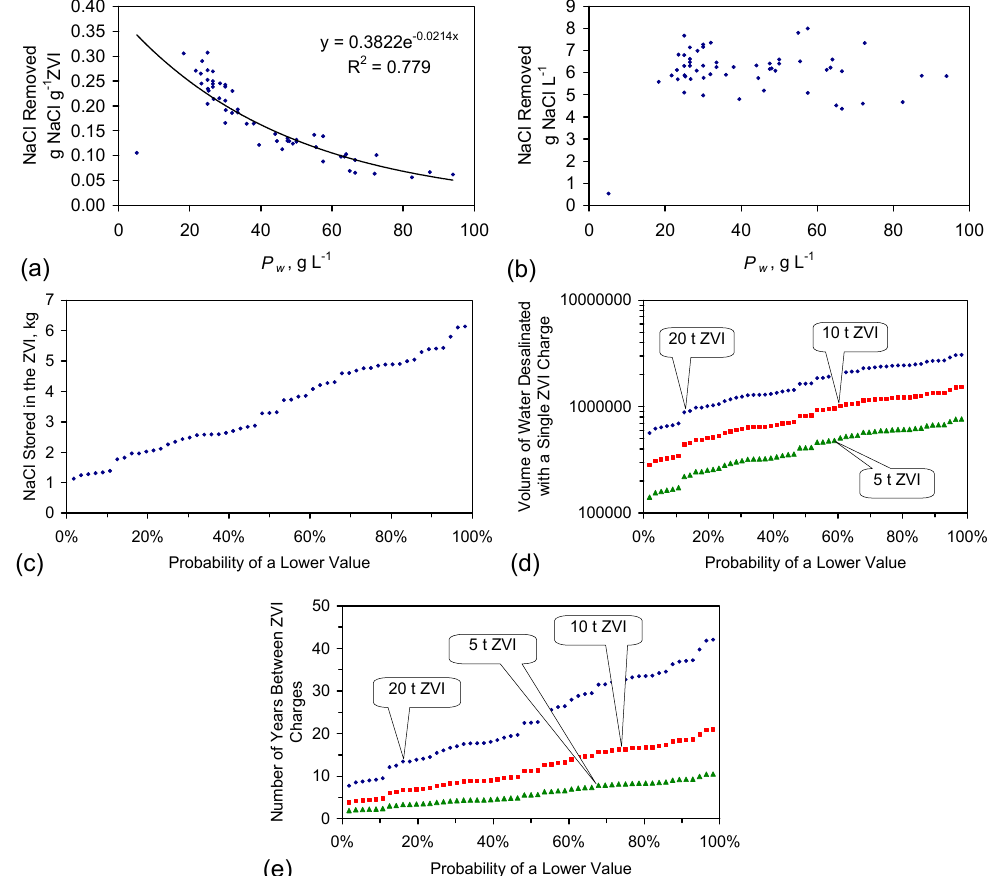
Figure 17. ST Desalination Pellets. Data Trial Duration: 230 days; n = 55; Data Source: [16]. ( a ) Relationship between NaCl removed (g·g − 1 ZVI) and P w , g NaCl·g − 1 ZVI: Data [16]; ( b ) Relationship between the total amount of NaCl removed, g·L − 1 , and P w , g NaCl·g − 1 ZVI: Data [16]; ( c ) Implied relationship between probability and the amount of NaCl (kg) that can be sequestered in 20 kg of pellets. Mean = 3.45 kg; Standard Deviation = 1.44 kg; 1st Quartile = 2.30 kg; Median = 3.29 kg; 3rd Quartile = 4.77 kg; ( d ) Volume of water than can be treated by a single ZVI charge before the ZVI needs to be recharged as a function of the amount of ZVI placed in a 4000 m 3 treatment zone where the aquifer salinity is 4 g/L and the irrigation water product salinity is 2 g/L; ( e ) Number of years between ZVI charges (or ZVI regeneration interval) vs. probability.